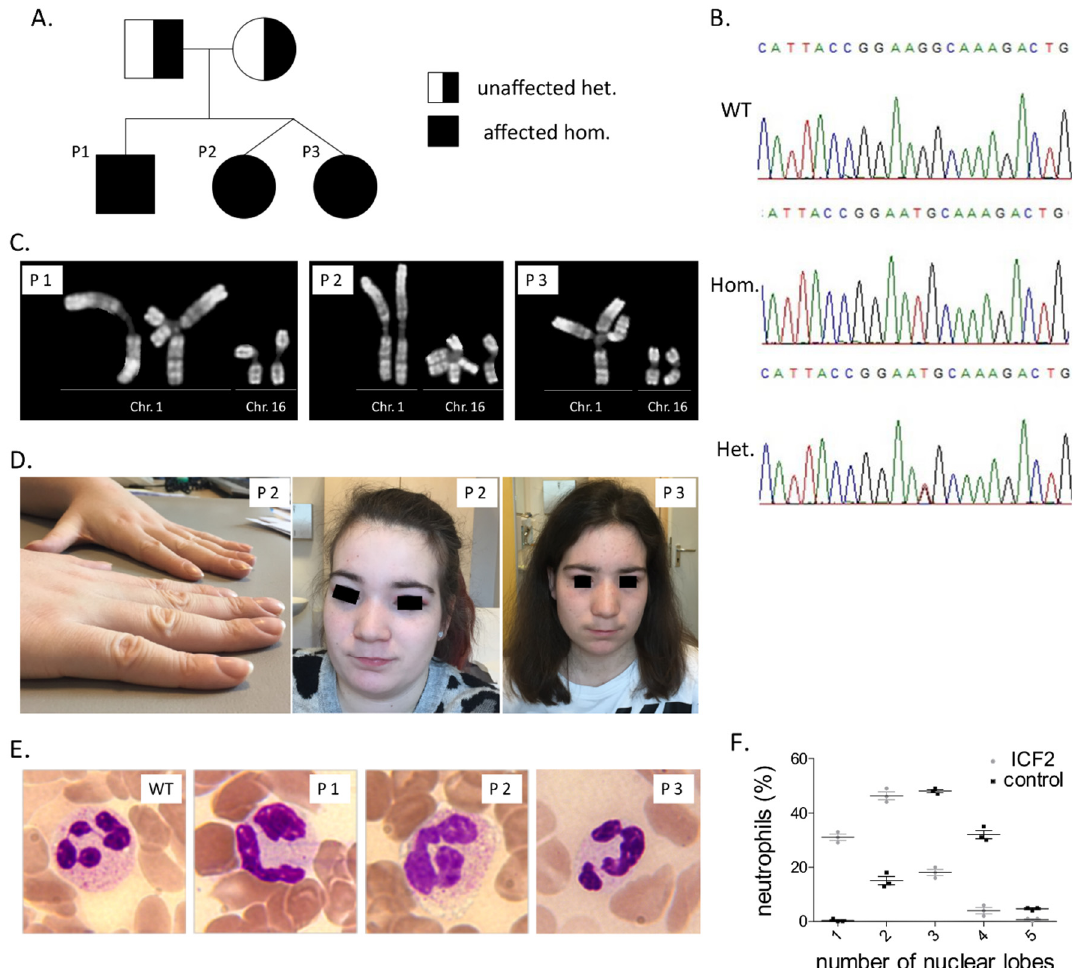
Figure 1. Segregation of ZBTB24 c.1222 T > G mutation in studied patients’ family. Pedigree ( A ) and representative sequencing chromatograms ( B ) are depicted. ( C ) Representative images of all three studied patients showing spontaneous under-condensation of subcentromeric constitutive heterochromatin of chromosomes 1 and 16 as well as multibranched chromosomes. ( D ) Flat nasal bridge in patients P2 and P3 and nail clubbing in patient P3. ( E ) Blood smears stained with hematoxylin-eosin, depicting pseudo-Pelger–Huët anomaly of neutrophils, magnification: 100 × . ( F ) Dot plot of nuclear lobe numbers of neutrophils of the three patients and three healthy blood donors.